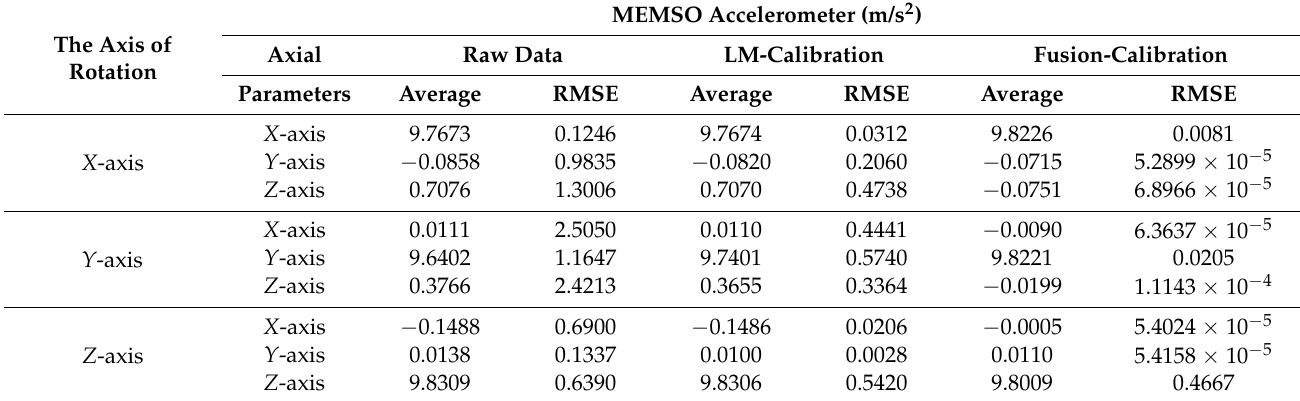
Table 9. Comparison of MEMS0 accelerometer parameters under dynamic conditions.